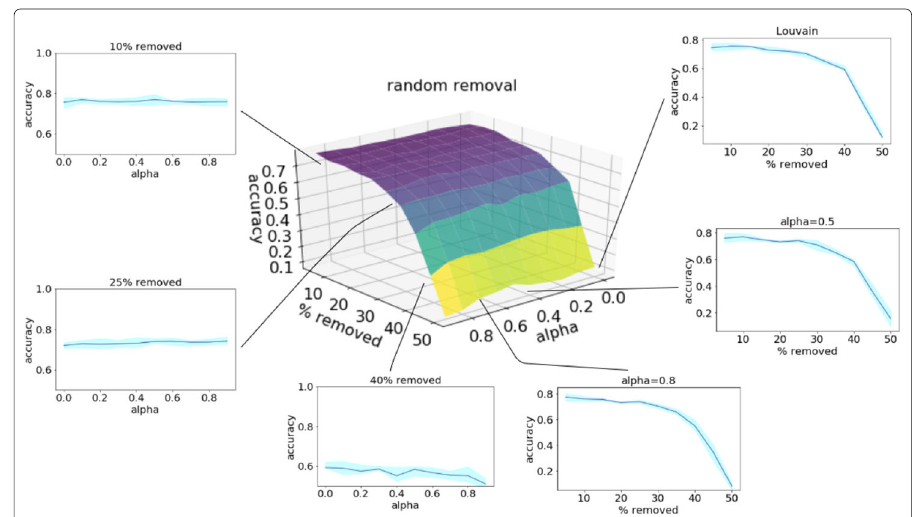
Fig. 4 Node label prediction: random node removal scenario in Cora network. Average values of accuracy over 10 executions: around the 3D plot are shown the projections of α vs. accuracy and percentageofnodes removed vs. accuracy (with interquartile